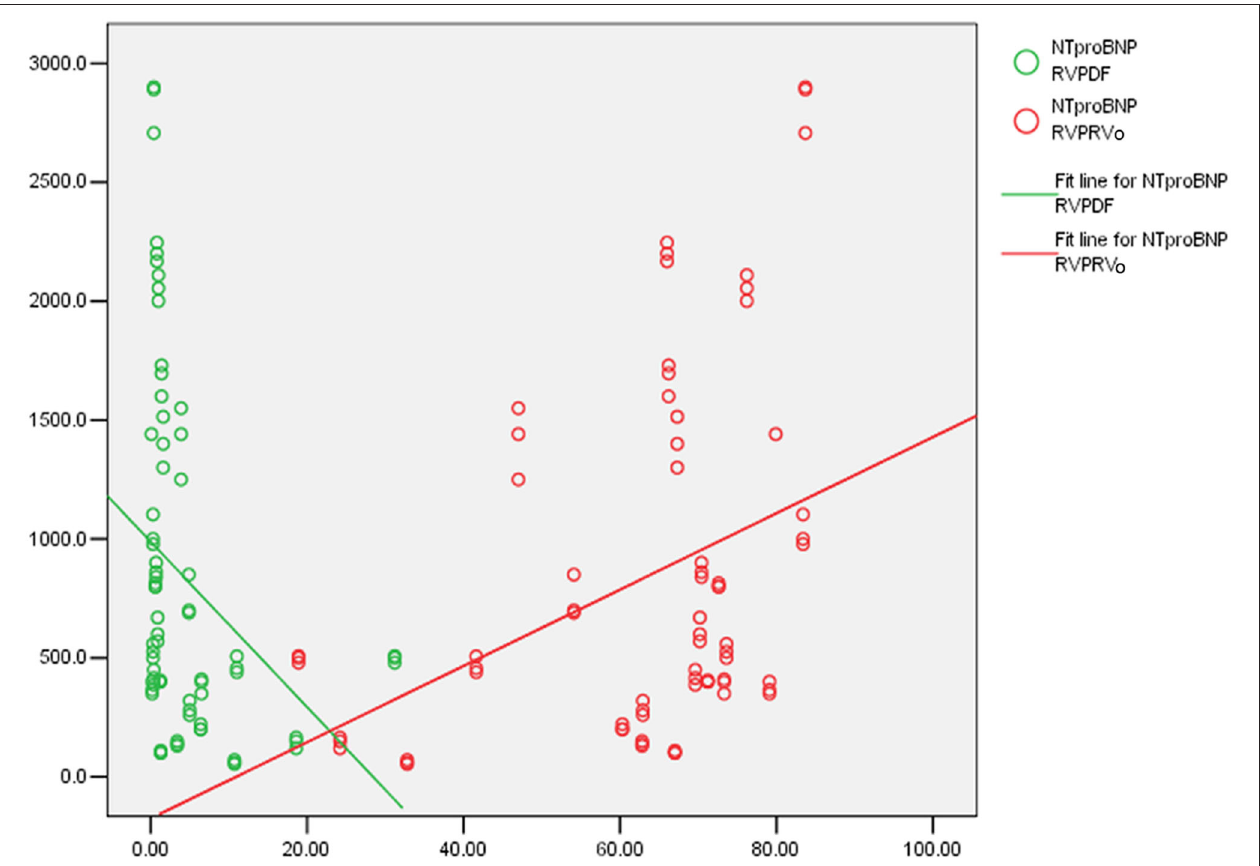
FIGURE 4 | The correlation of the percent of direct flow (PDF), the percent of residual volume (PRVo) and serum N-terminal pro-brain natriuretic peptide (NT-proBNP): (Green) PDF negatively correlated with NT-proBNP. (Red) PRVo positively correlated with NT-proBNP.